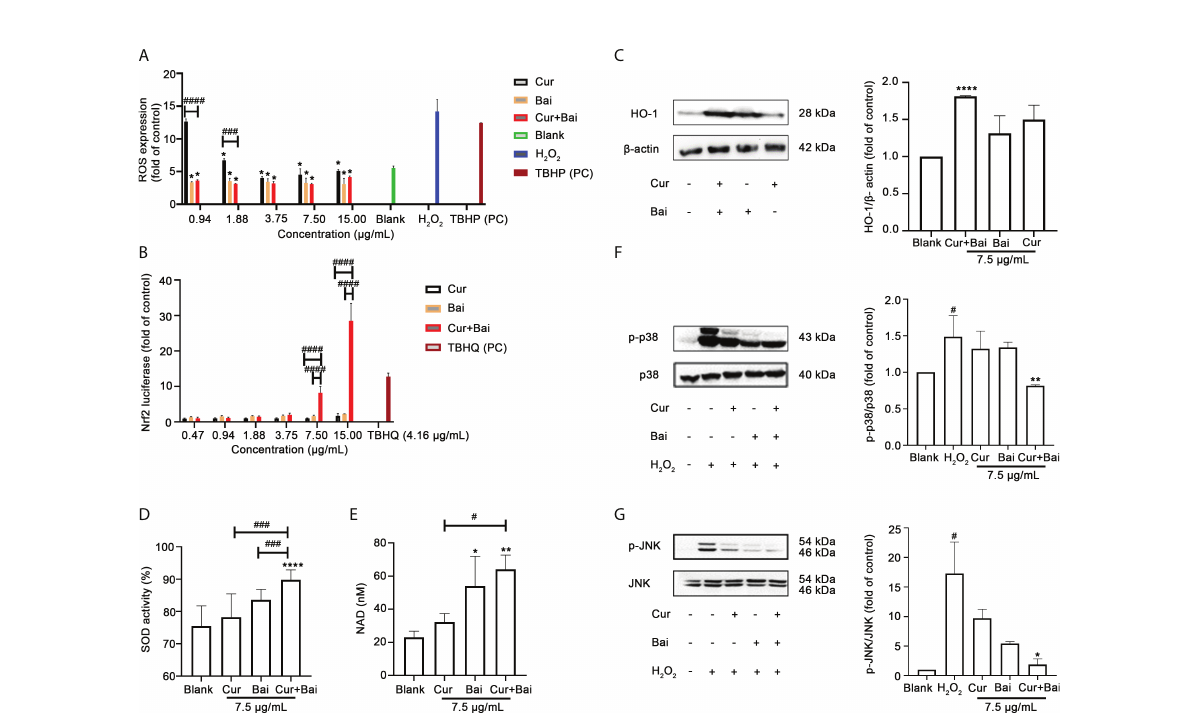
FIGURE 2 Cur+Bai attenuated H 2 O 2 -induced endothelial damage in EA. hy926 cells which may be associated with regulating Nrf2-HO-1 and MAPK pathways. (A) ROS expression in EA. hy926 cells pretreated with Cur, Bai or Cur+Bai with serial dilutions from 15 m g/mL and stimulated with H 2 O 2 for 4 h. TBHP (50 m M) was used as the positive control. The ROS expression was presented as the fold change to the blank control (cells with media only). * p <0.05 vs. H 2 O 2 only. ### p <0.001, #### p <0.0001 vs. Cur or Bai at the same concentration level. n=3 individual experiments. (B) Nrf2 luciferase under the treatment of Cur, Bai or Cur+Bai (0.47-15 m g/mL). The Nrf2 luciferase was presented as fold change to that of the blank control (cells with media only). TBHQ was used as the positive control. #### p <0.0001 vs. Cur or Bai at the same concentration level. n=3 individual experiments. (C) The up-regulatory activity of Cur+Bai on HO-1/beta-actin which was greater than that of Cur or Bai alone (7.5 m g/ mL) as assessed by the Western blot analysis (n=3 individual experiments). **** p <0.0001 vs. blank. Cur+Bai increased cellular SOD (D) and NAD (nM) (E) productions. * p <0.05, ** p <0.01 vs. blank; # p <0.05, ### p <0.001 vs. Cur or Bai at the same concentration level (7.5 m g/mL). The error bars represent the standard deviation of measurements for over three samples in three separate assay runs (n=3). (F, G) Cur+Bai (7.5 m g/mL) downregulated the phosphorylation of MAPKp38 and JNK as assessed by the Western blot analysis (n=3 individual experiments). # p <0.05 vs. blank control. * p <0.05, ** p <0.01 vs. H 2 O 2 . Results were expressed as mean ± standard deviation for at least three individual experiments. The p values were obtained from one-way ANOVA